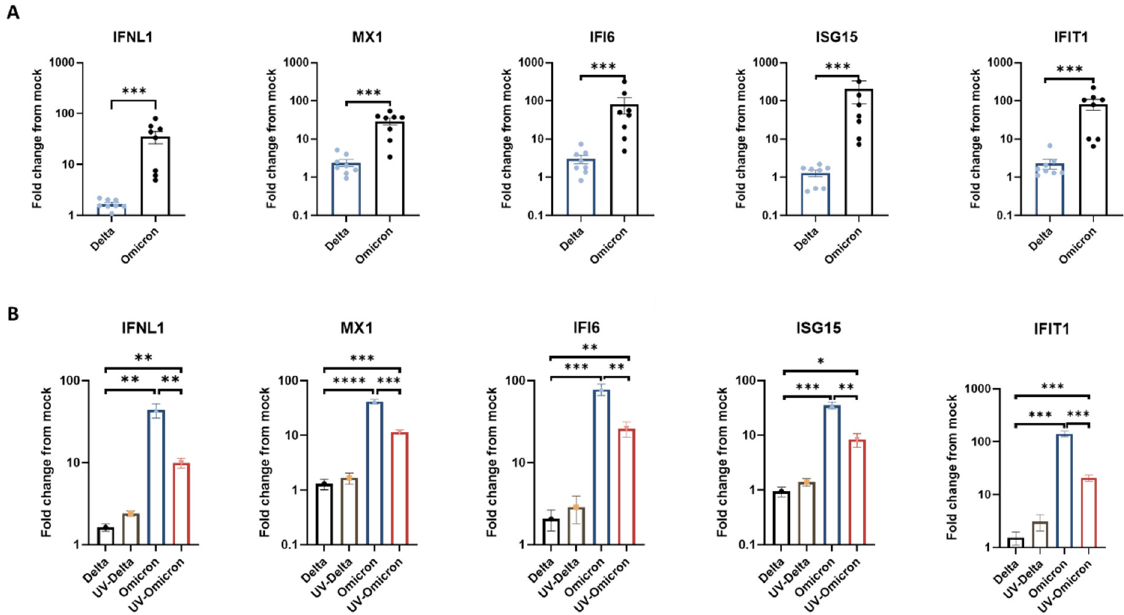
Figure 2. Lung tissue interferon response to SARS-CoV-2 Omicron and Delta. Lung organ cultures were infected in parallel with Omicron and Delta (10 5 PFU/well), and the effect of infection on the expression of the indicated innate immunity genes, measured by RT-qPCR at 24h post-infection, is presented as fold-change from mock-infection. ( A ) the mean values ( ± SEM) in 8 independent tissues, each tested in 4 biological replicates. ( B ) the mean values ( ± SEM) in a representative tissue (tested in 4 biological replicates) exposed in parallel to infectious versus UV-inactivated viruses. The results shown in panel B represent at least three independent tissues. *, p < 0.05; **, p < 0.01; ***, p < 0.001; ****, p <